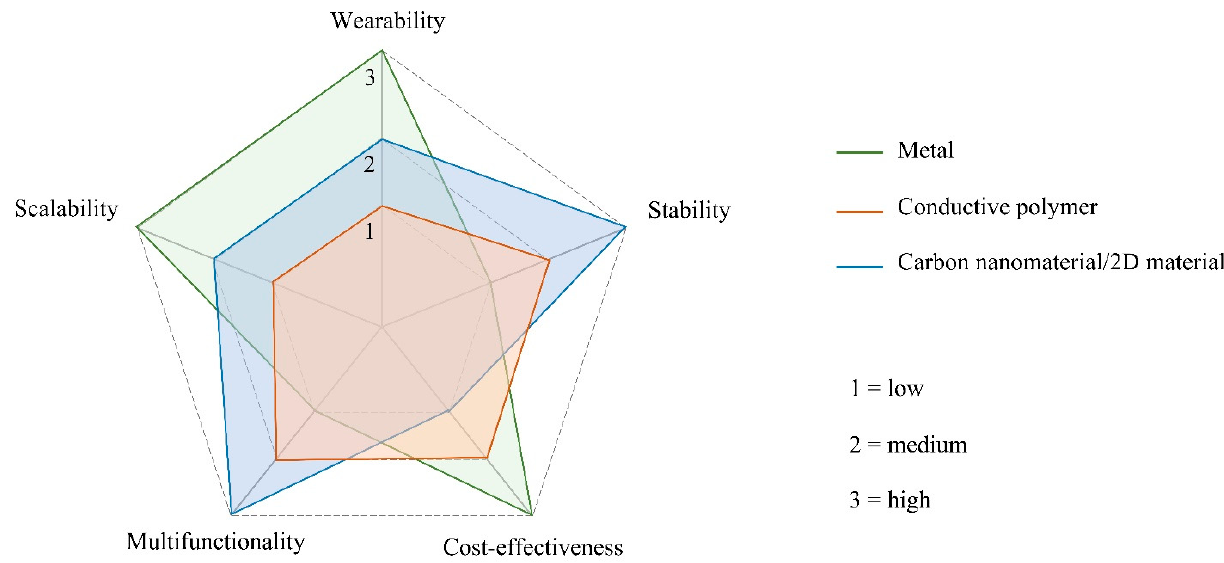
Figure 18. A radar plot showing a comparison of comprehensive performance among different functional materials for the design of textile-based sensors.